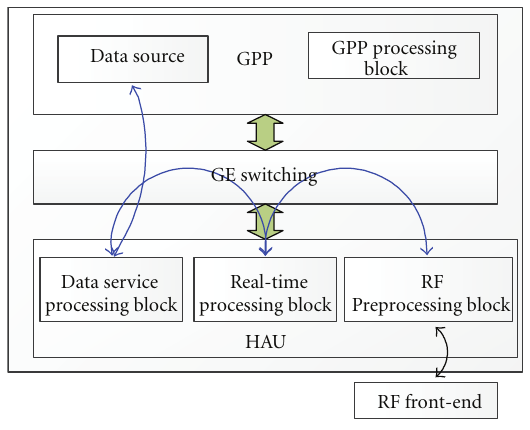
Figure 7: GE-based SDR